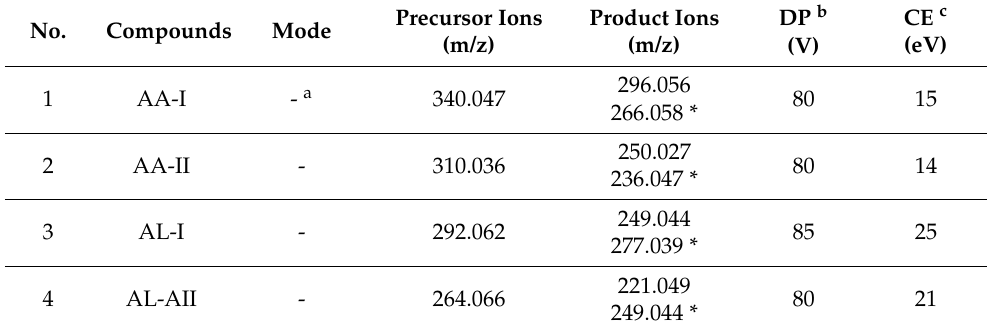
Table 2. Mass spectrometric parameters of target